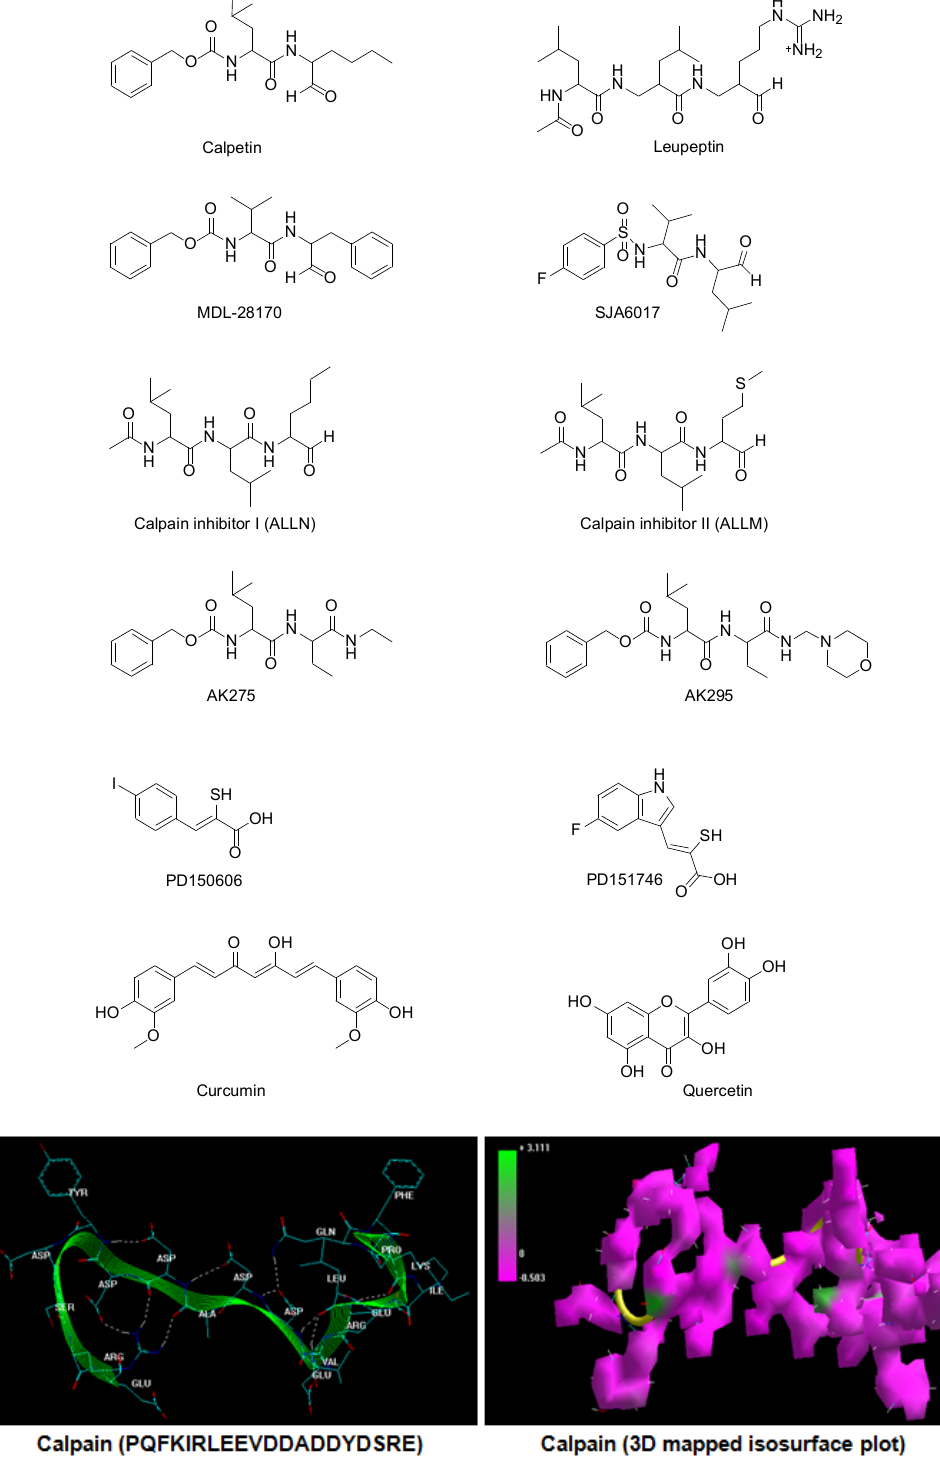
Figure 1. Chemical structures of calpain inhibitors and